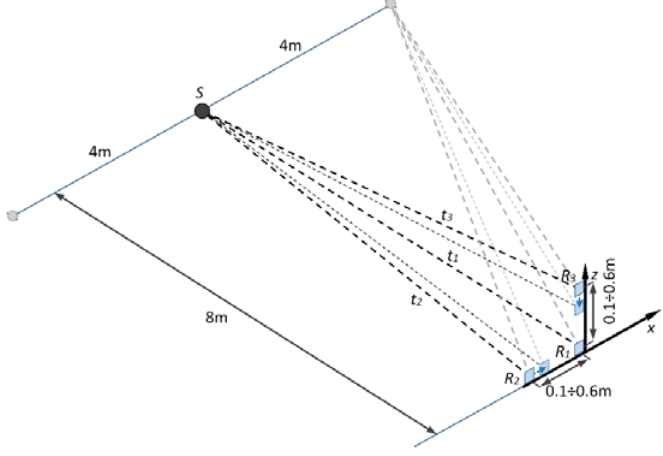
Figure 9. Positioning of the ultrasonic transducers during assessment of least on-axis distance between transducers.